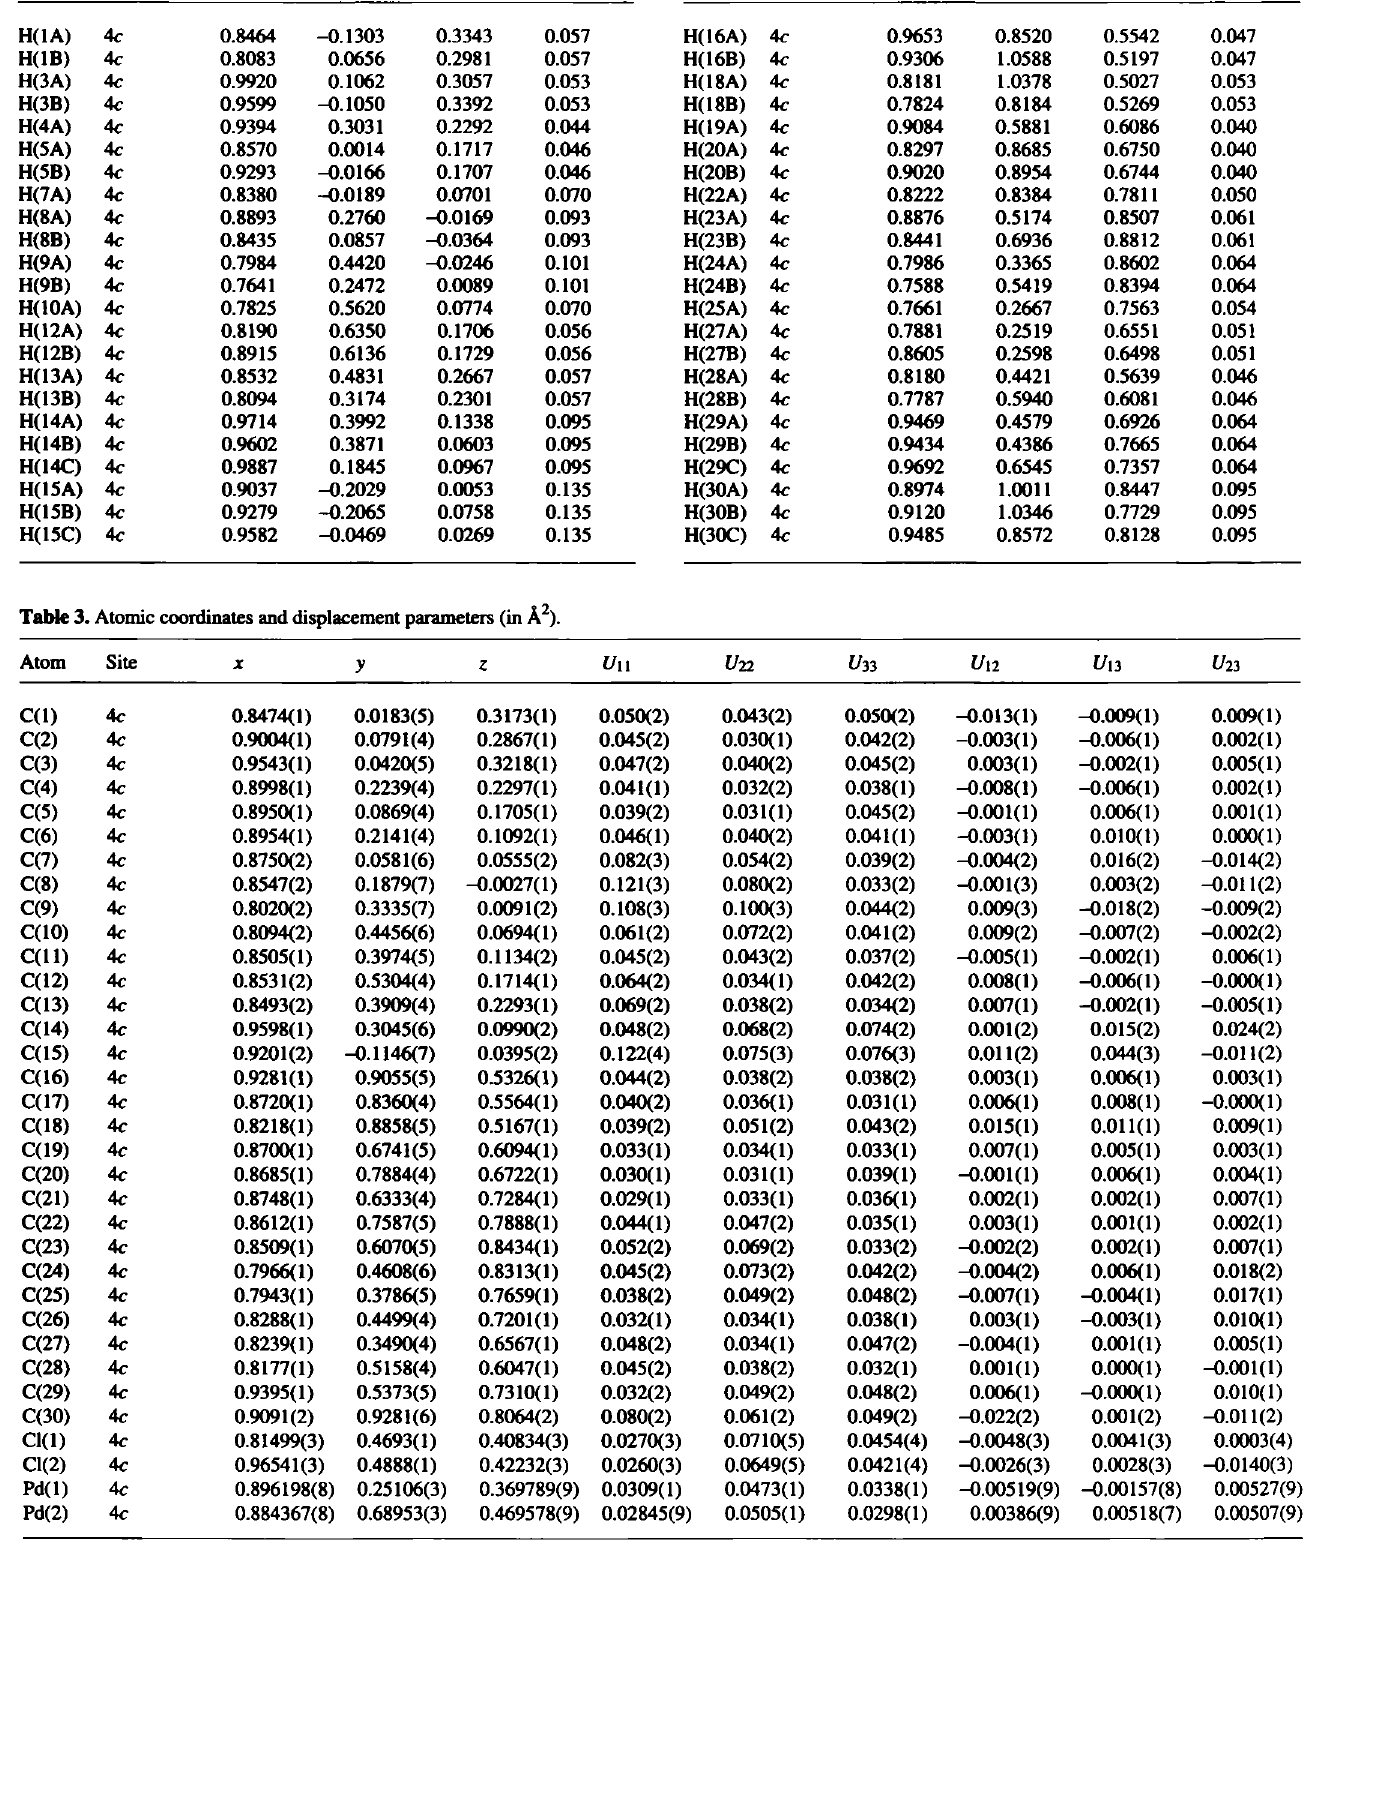
Table 3. Atomic coordinates and displacement parameters (in Â 2